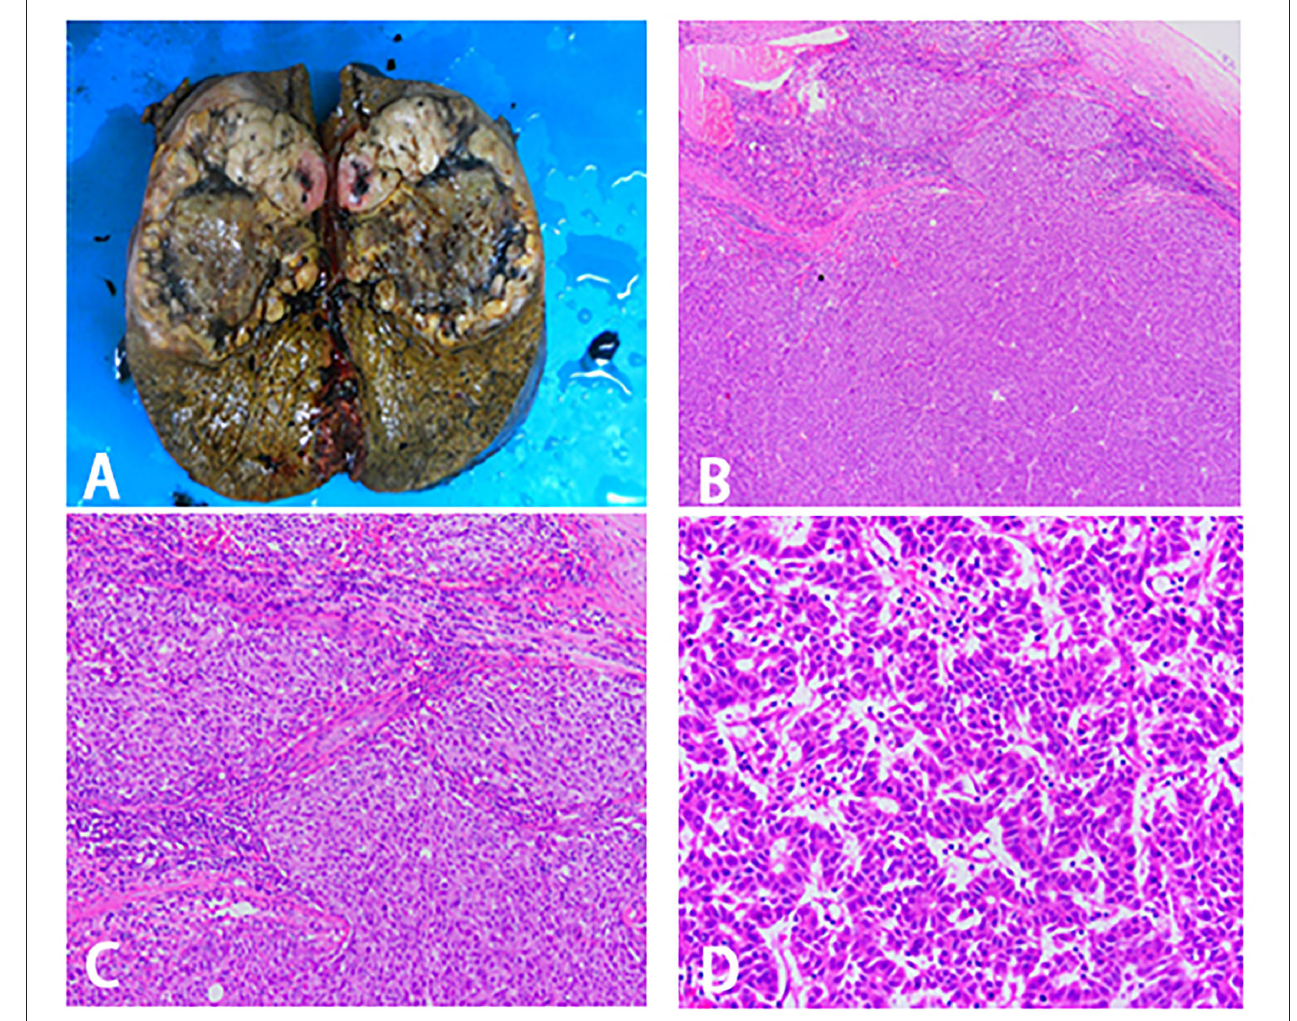
FIGURE 4 | Surgical specimen and histopathological images. (A) Right trisectionectomy specimen. (B–D) Pathological examination of tissue section. (B) 40X magnification. (C) 100X magnification. (D) 400X magnification.